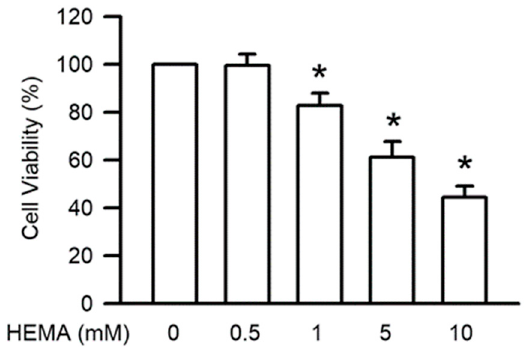
Figure 1. HEMA reduced cell viability in RAW264.7 cells. Cell survival was measured by the MTT test after 24 h of HEMA incubation. The value is expressed as the percentage of control cells treated with the vehicle. Results are expressed as means ± SD. The number of parallel measurements is 5. * means that p < 0.05 compared with HEMA at the concentration of 0 mM.